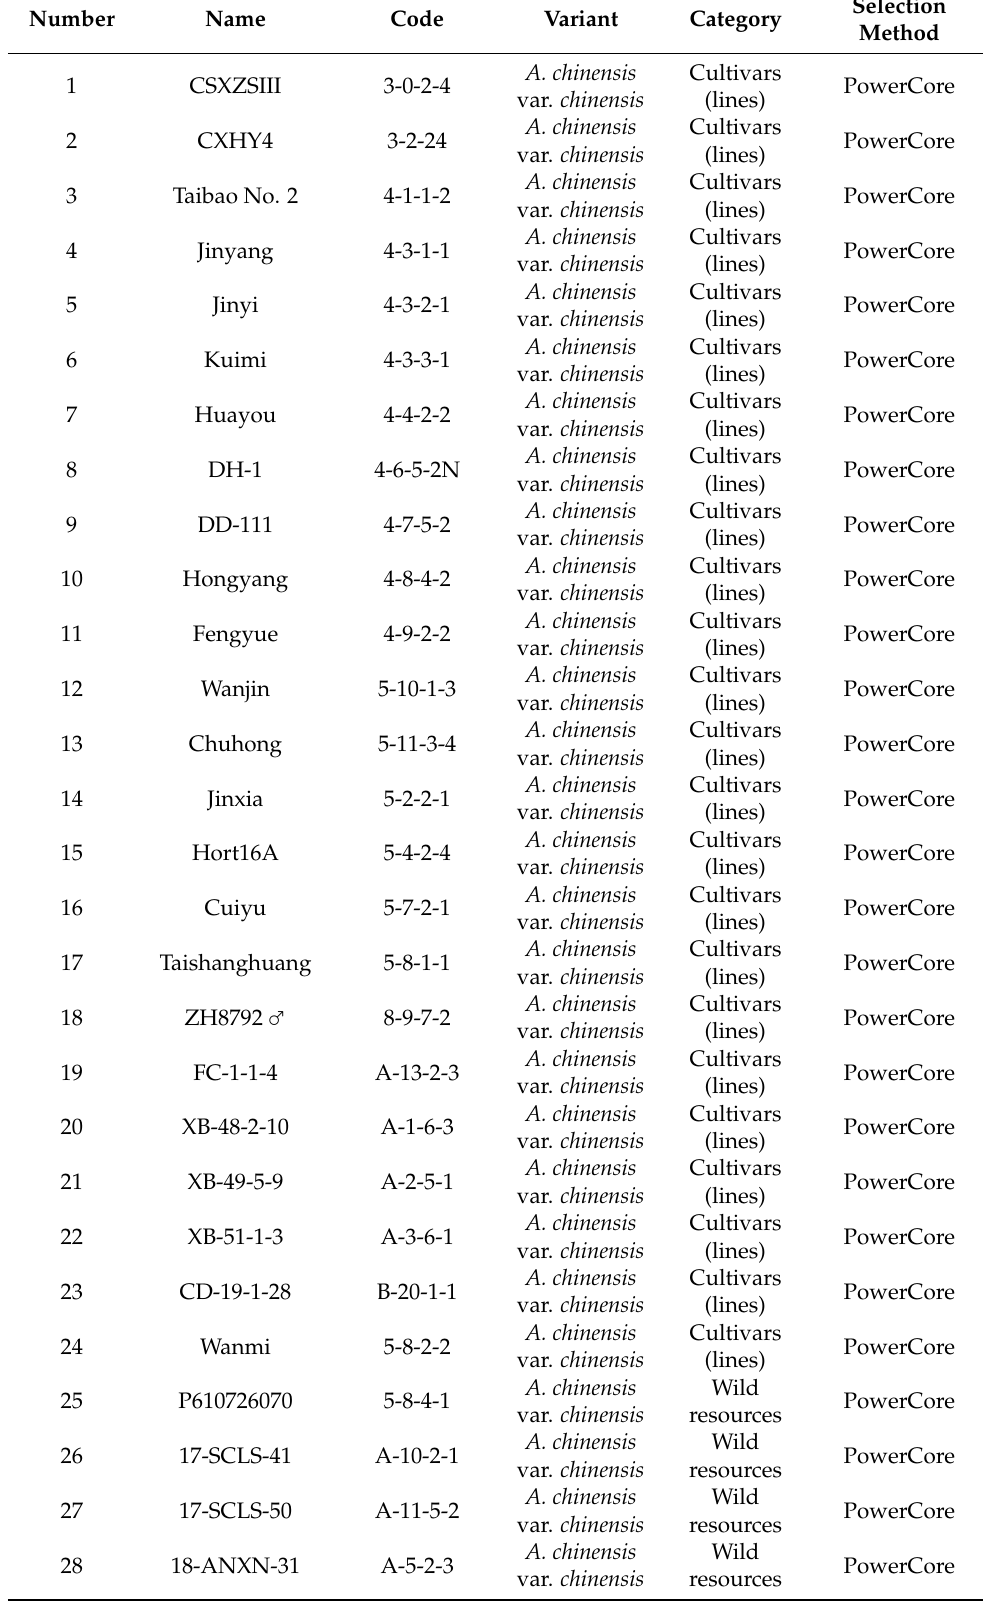
Table 4. Information on core germplasm resources of the A. chinensis